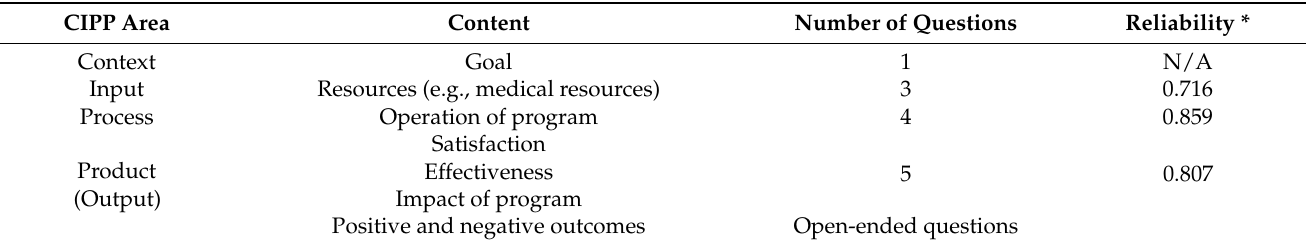
Table 2. Patients’ CIPP questionnaire content areas in the Follow-up Health Consultation Pro- gram